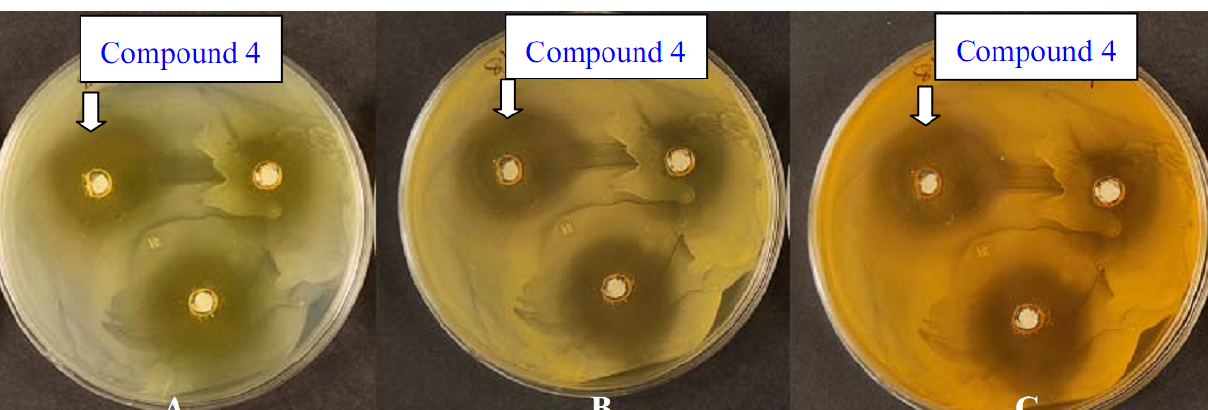
Figure 5. Staphylococcus aureus treated with 10 mg·mL − 1 of compound 4 after one day “A”, three day “B” and six days “C” of